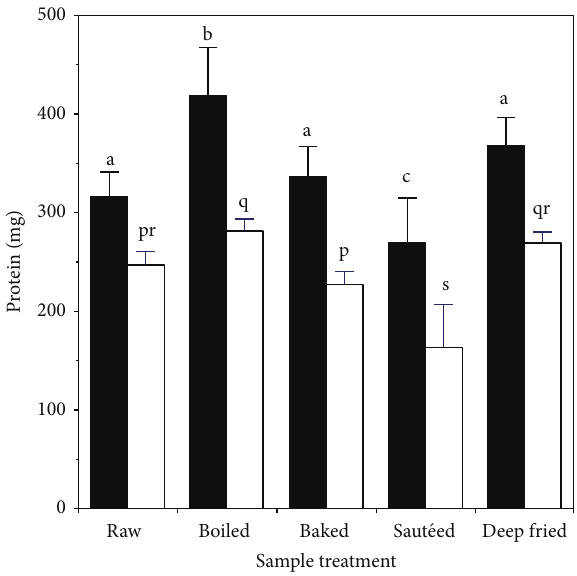
Figure 5: Effect of heating on production of nonprotein sulfhydryls during acid extraction of chicken muscle. Values are the mean ± standard deviation ( 𝑛 = 6 ). Means without a common letter differ at 𝑃 < 0.05 .